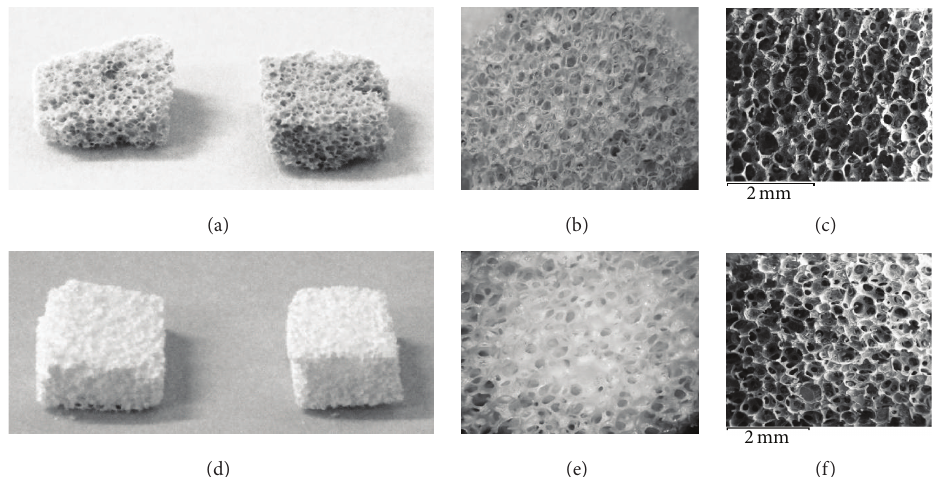
Figure 2: Digital camera photographs (a, d), light microscope images of different magnifications (b, e), and SEM microphotographs (c, f) of the glass-ceramic scaffolds (a, b, c: CuA2, d, e, f: ZnA2).